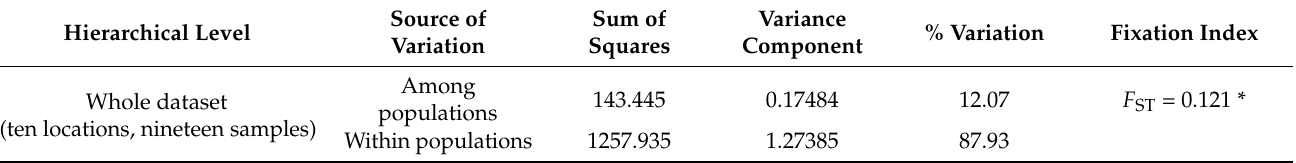
Figure 4. Spatial mixture clustering analysis performed by BAPS on GPS coordinates (latitude and longitude) of each sample were set according to fishing records. Different colors indicate different gene pools as recovered with BAPS. Table 4. Hierarchical AMOVA on the variation of microsatellites in P. americanus from both Hemi- spheres. Asterisks indicate the probability that observed values were equal or smaller than those expected by chance, * p ≤ 0.01; ns: